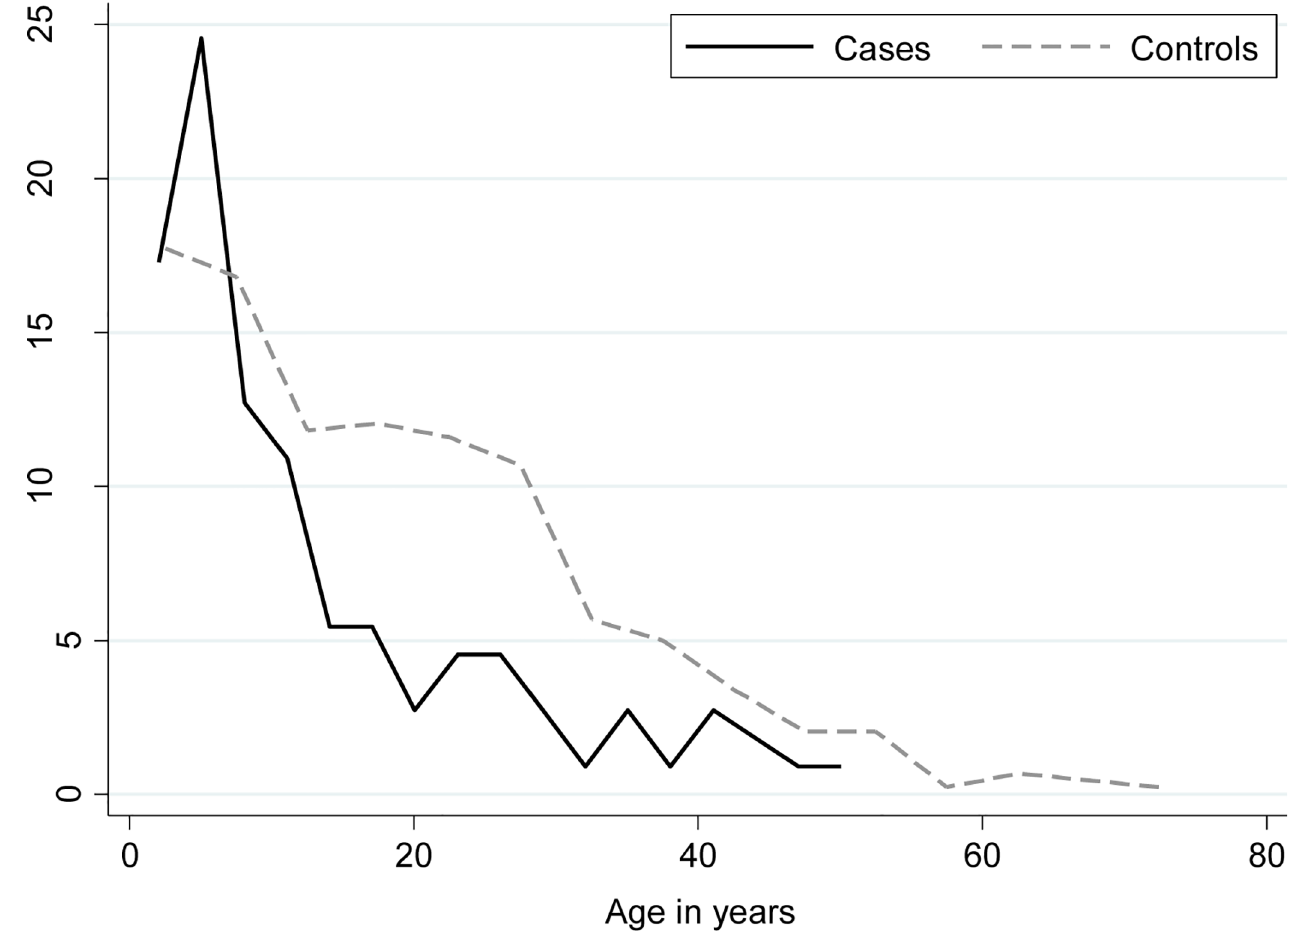
Fig 2. Distribution (by percentage of total) of 110 typhoid fever infections and 440 population-based controls by age in Kibera.